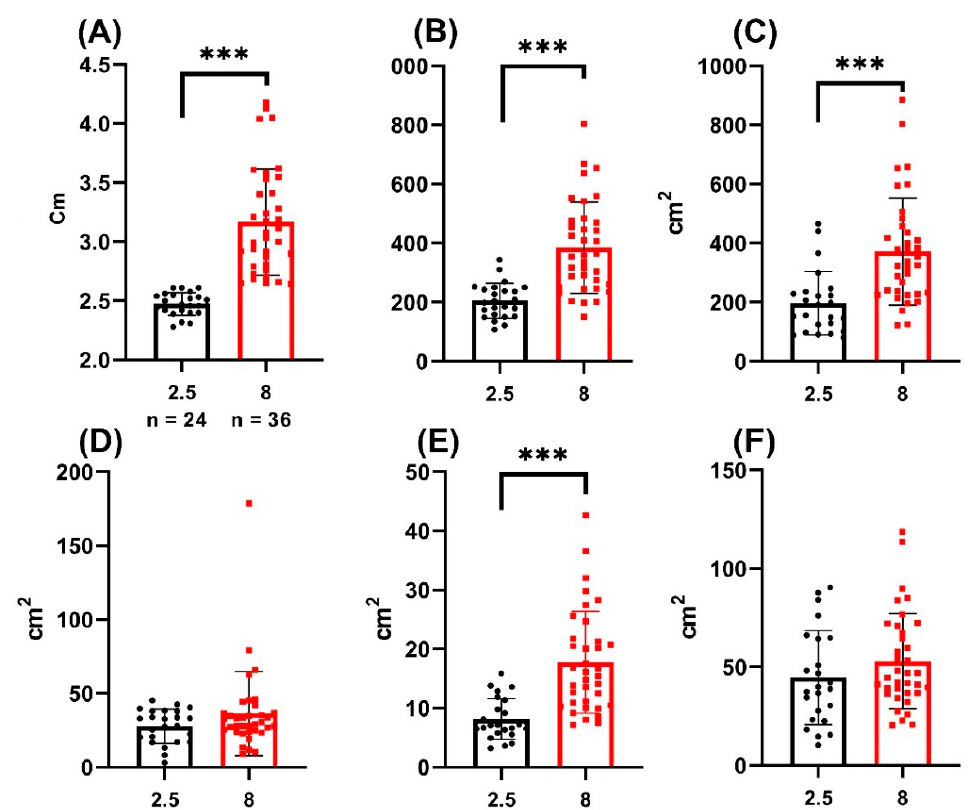
Figure 6. Comparison of the coloration areas of different zones of males of different age groups (2.5- and 8-month post-hatching). The value (*** p < 0.001) from one-way ANOVA with comparison using Tukey’s post hoc analysis. ( A ) fish length; ( B ) LBRIO zone; ( C ) RROI zone; ( D ) RSGC zone; ( E ) BROI zone; ( F ) BBCF